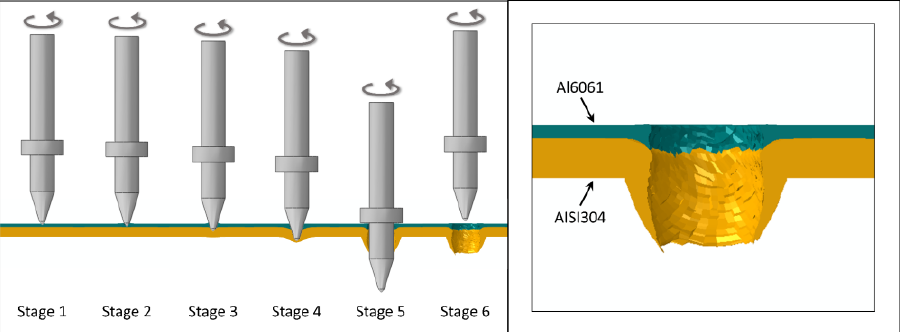
Figure 2. Process stages involved in the friction drill joining process.